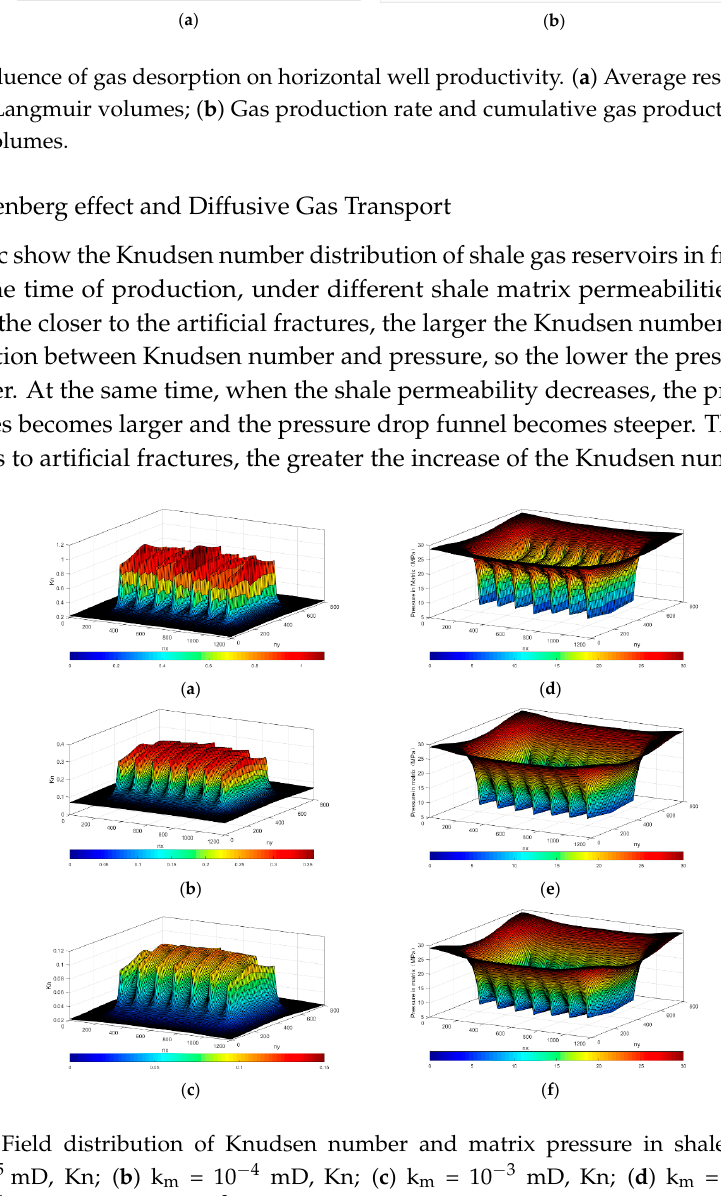
Figure 9. Influence of gas desorption on horizontal well productivity. ( a ) Average reservoir pressure at different Langmuir volumes; ( b ) Gas production rate and cumulative gas production at different Langmuir volumes.